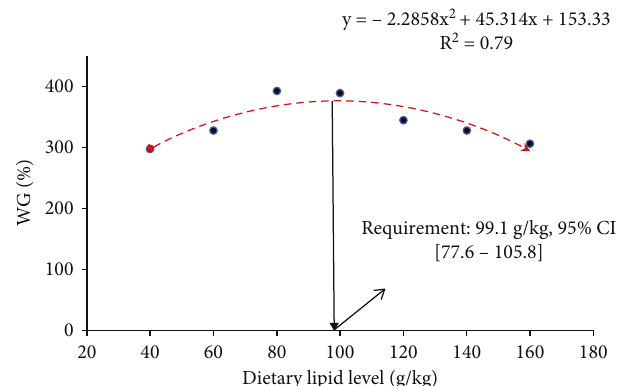
Figure 1: In relation to weight gain percentage (WG%), second order polynomial regression model indicates the optimum dietary crude lipid requirement (g/kg) of GIFT juveniles reared in IGSW of 15ppt for 60 days (ANOVA: F interval, CI for mean at 95% level = 324 : 31 -358.32).